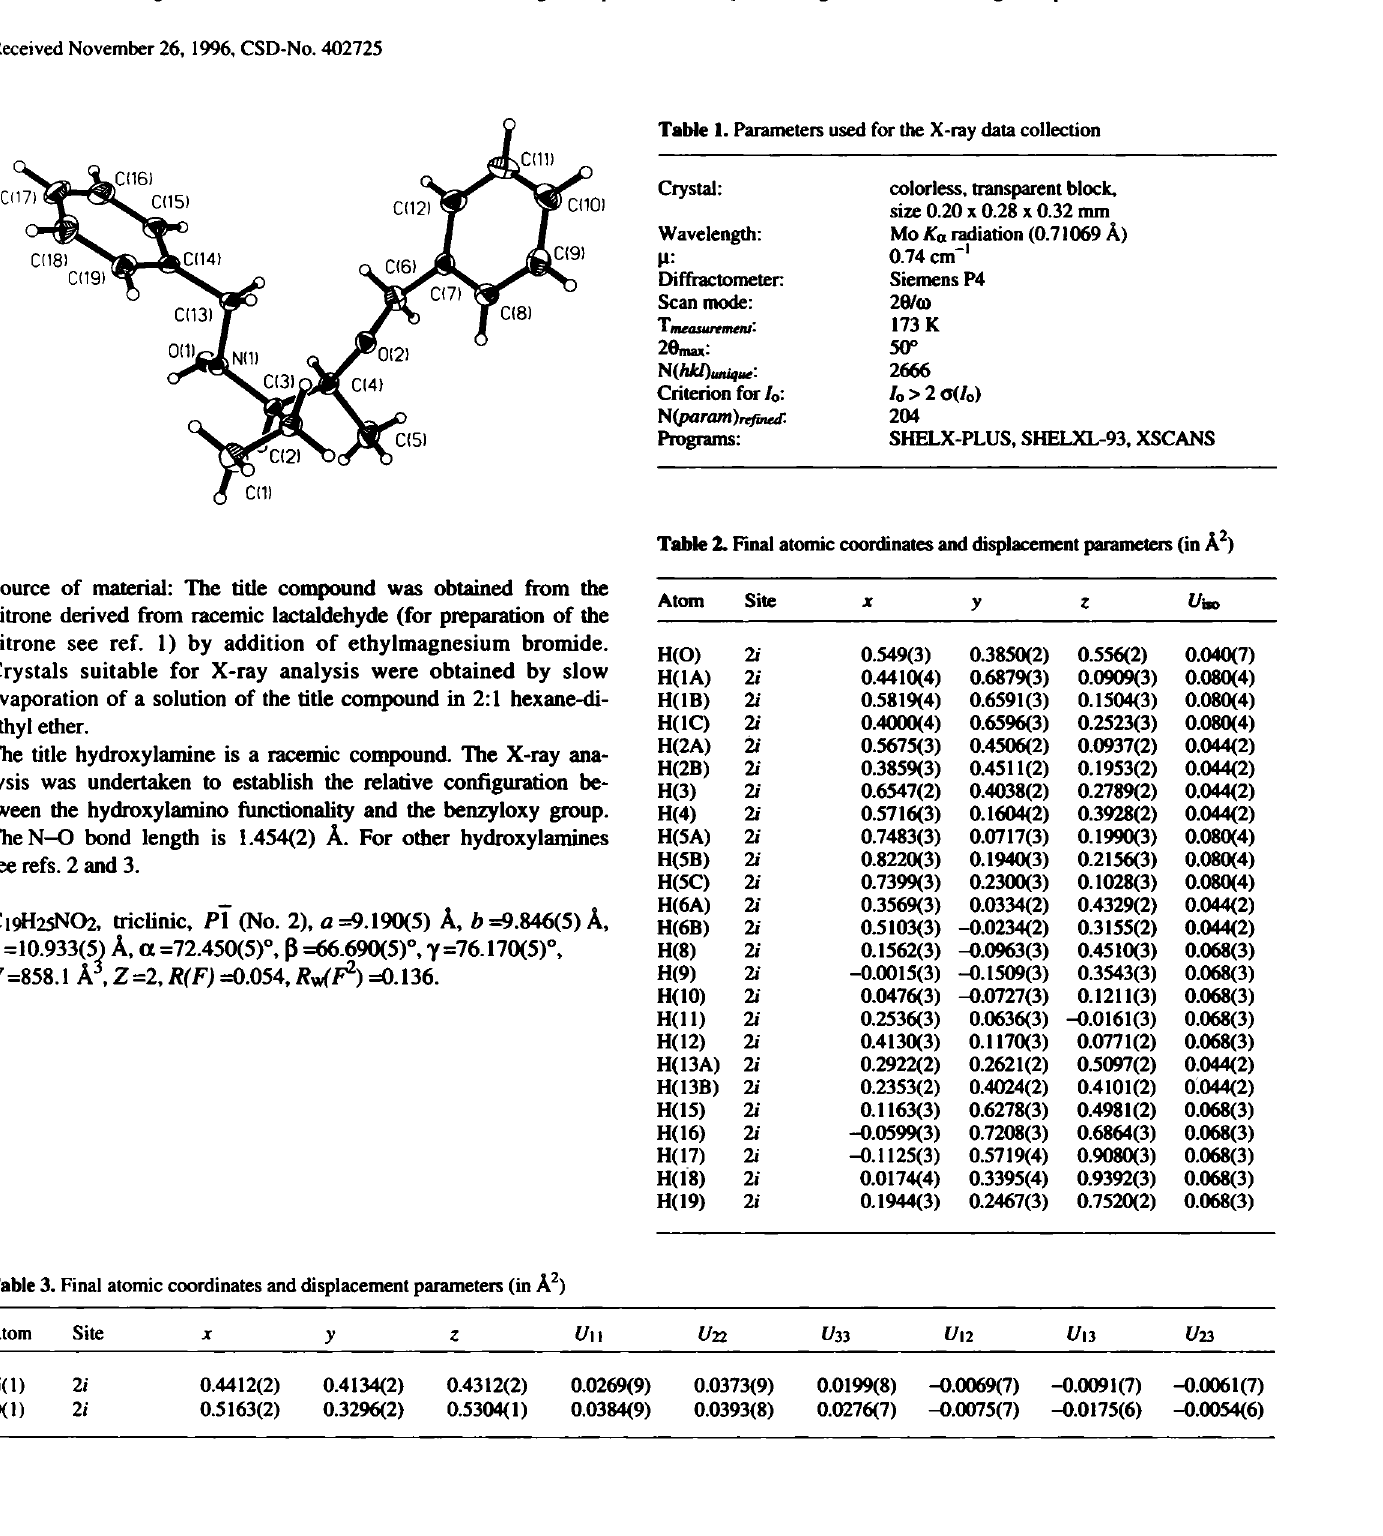
Table 3. Final atomic coordinates and displacement parameters (in À 2